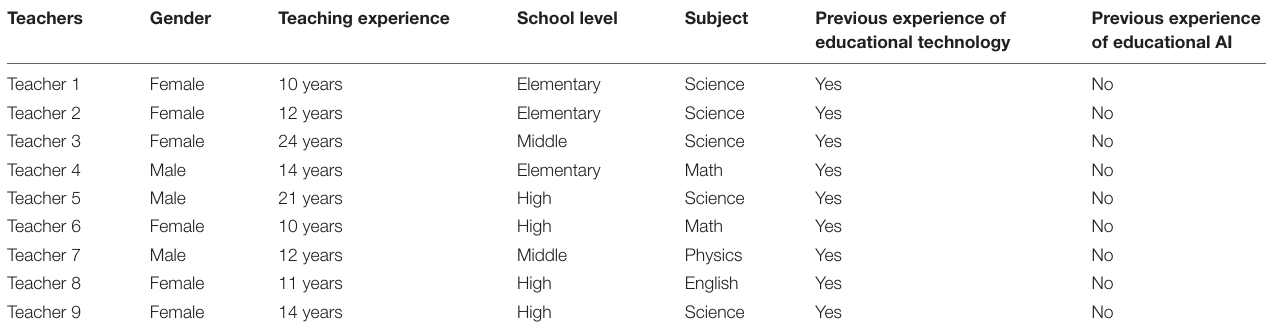
TABLE 1 | Participants’ background